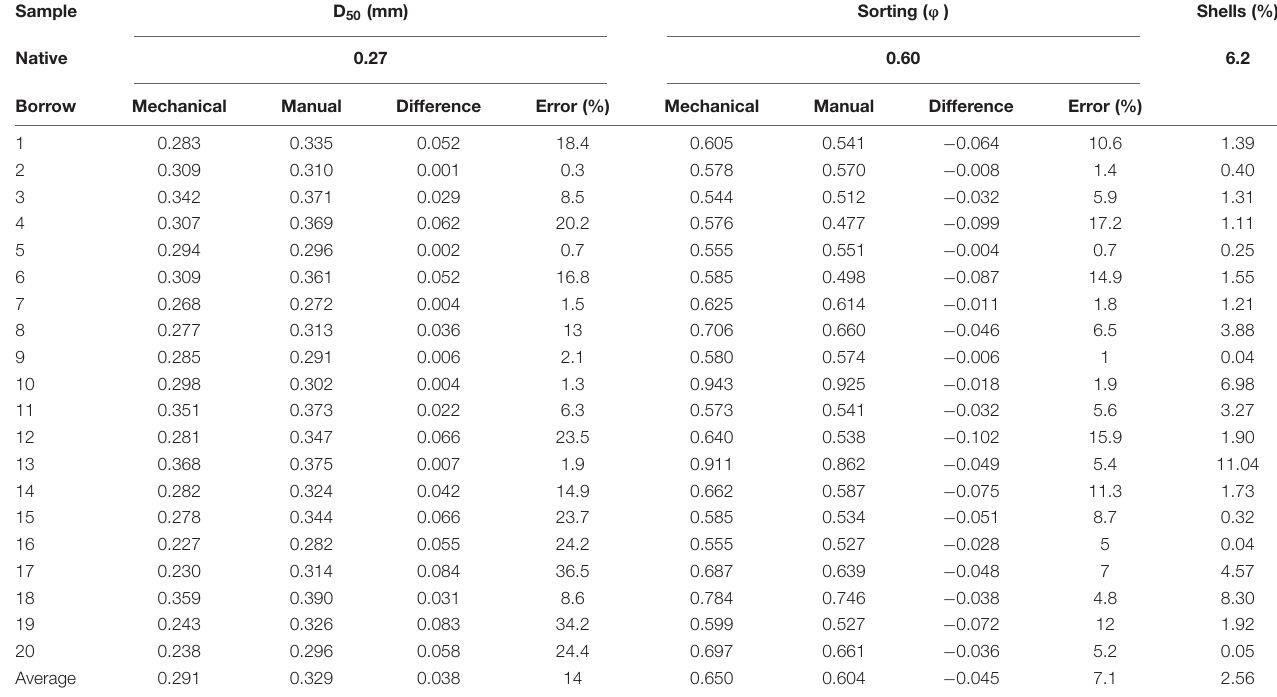
TABLE 2 | Granulometric parameters of 20 sand samples including D 50 (mm) and sorting ( ϕ ), and difference (mm) and error (%) between methodologies for mechanical and manual sieving methods with 10 cm diameter sieves. Sample Sorting ( ϕ ) Shells